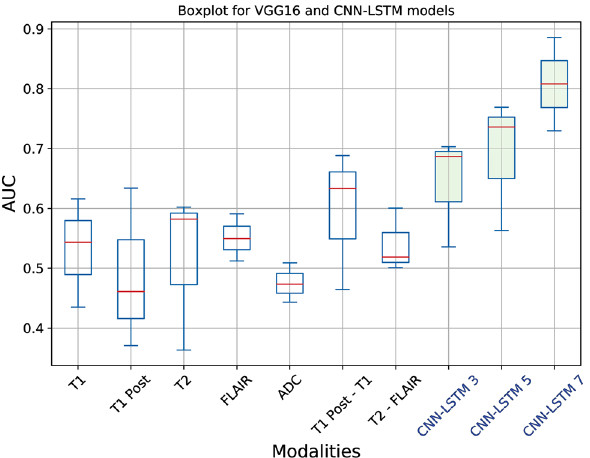
Figure 3. Boxplots of AUC for VGG16 and CNN-LSTM models. The first seven box plots are for VGG16 with an individual MRI sequence, and last three box plots are for CNN-LSTM with multiparametric MRI sequences. Statistics were collected from threefold cross validation and the red lines in the boxplots represent the median